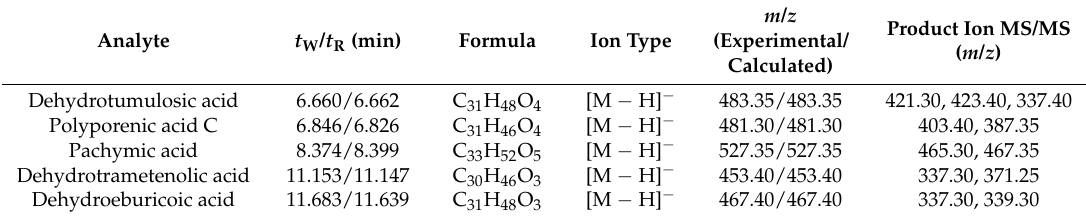
Table 4. ESI-MS/MS data of constituents identified from the collected eluates of W. cocos.